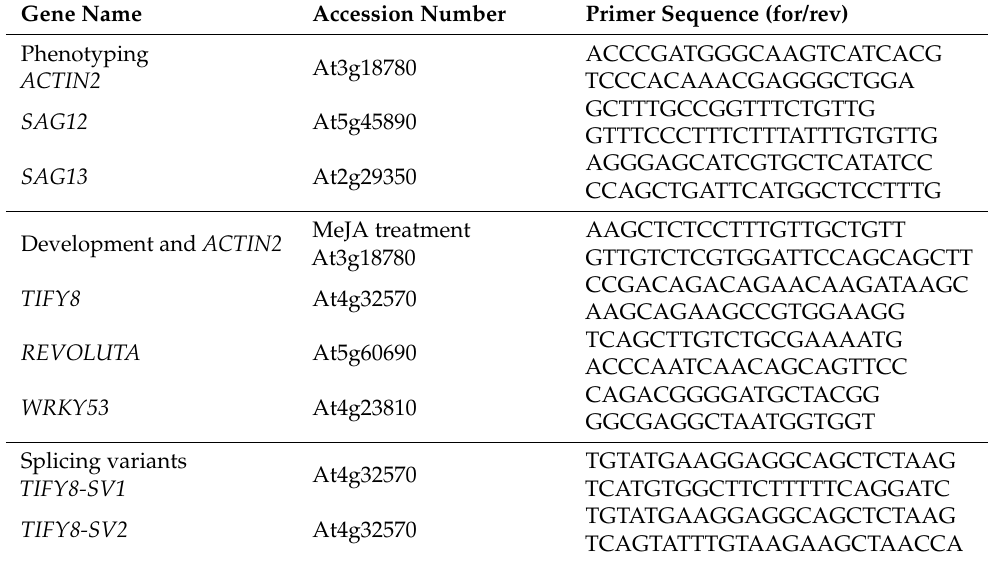
Table 3. Primers for